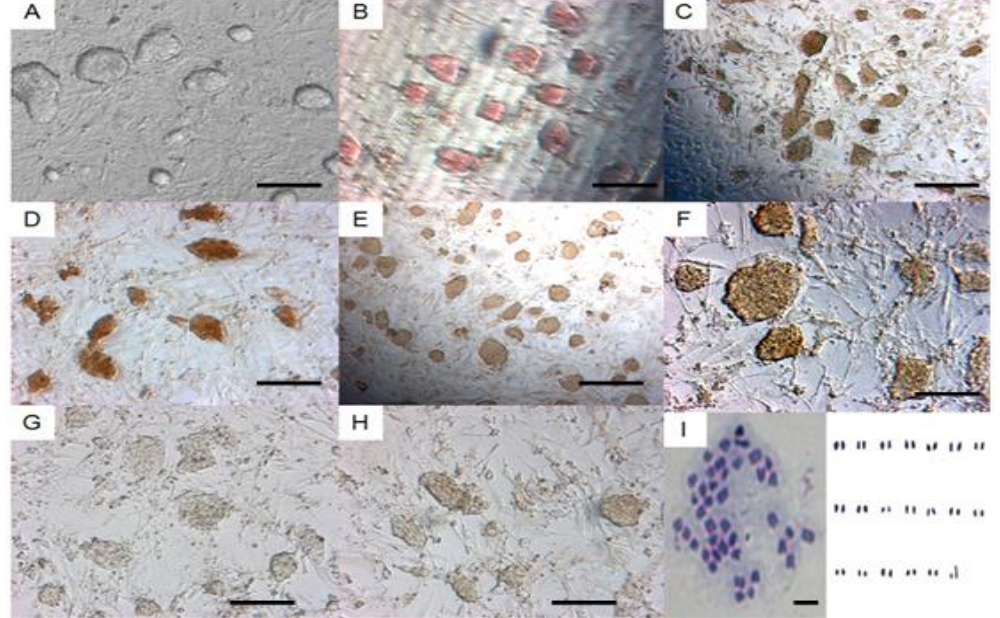
Figure 2. Karyotypes and immunohistochemical characterization of the isolated ES